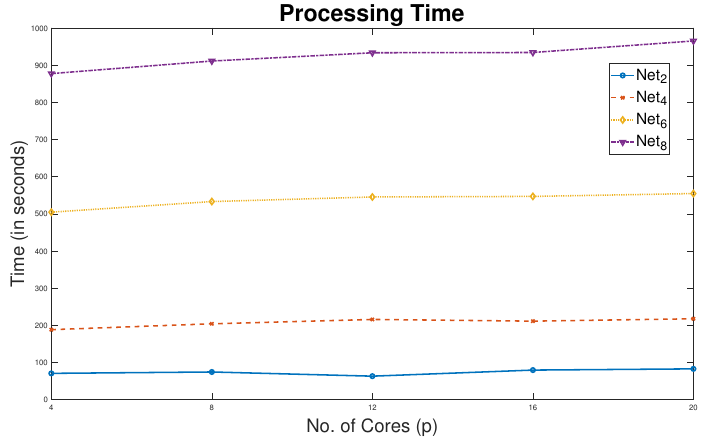
Figure 12. Parallel processing time of pSSEF with Net 80